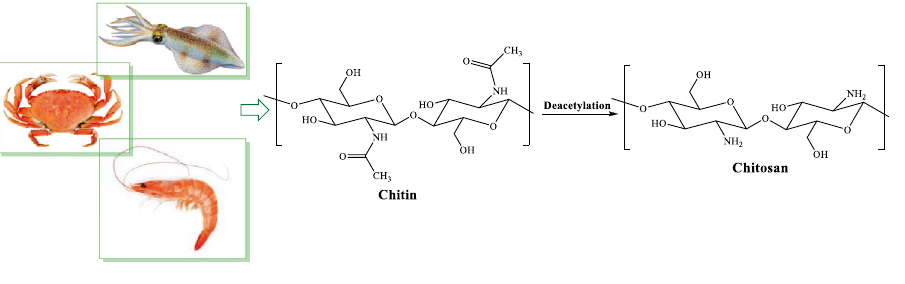
Figure 1. Natural sources of